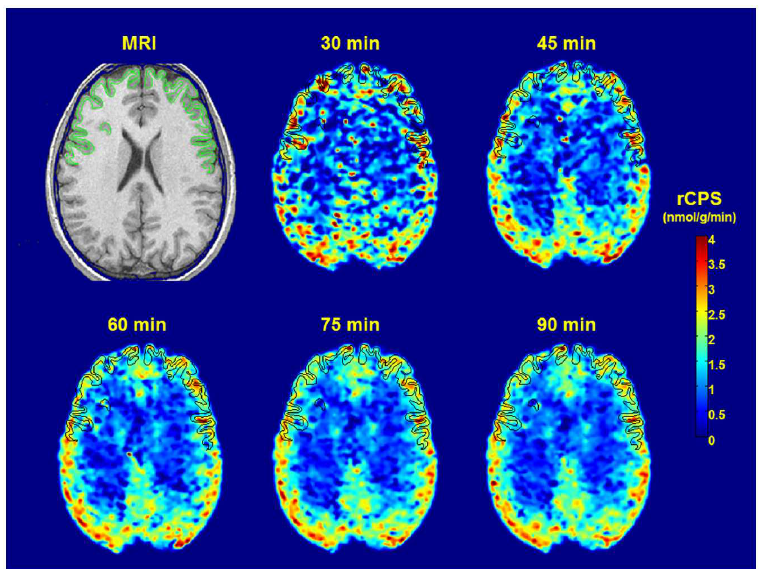
Fig 4. Parametric images of rates of cerebral protein synthesis (rCPS). Data from a L-[1- 11 C]leucine PET study of a healthy awake 22 year old male subject. Kinetic model parameters of the homogeneous tissue kinetic model and rCPS were estimated with the Basis Function Method over the intervals 0–30, 0–45, 0–60, 0–75, and 0–90 min. A Gaussian filter (2.0 mm FWHM kernel) was employed to smooth the parametric images in three dimensions before visualization. The MRI Image to which the PET images were coregistered is shown at the upper left. All images are in transverse plane on which the frontal cortex has been outlined.